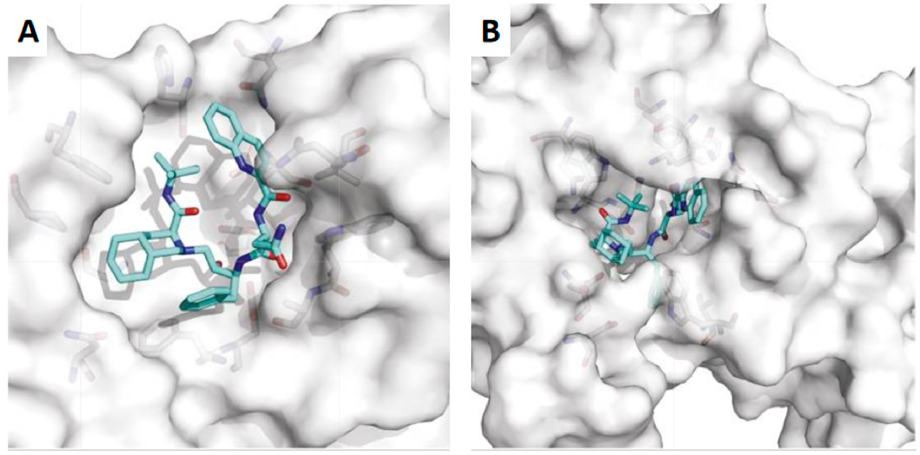
Figure 4. Proposed model of inhibition of the SARS-CoV-2 NSP14 by saquinavir (PDB ID 5NFY). ( A ) Saquinavir interaction with the N -terminus of NSP14; ( B ) saquinavir interaction with the C- terminus of NSP14. Adapted from [28]. Another target in this vein could be the NSP12–NSP7–NSP8 complex, in which NSP12 is essential for RNA-dependent RNA polymerase synthesis (RdRp) needed for